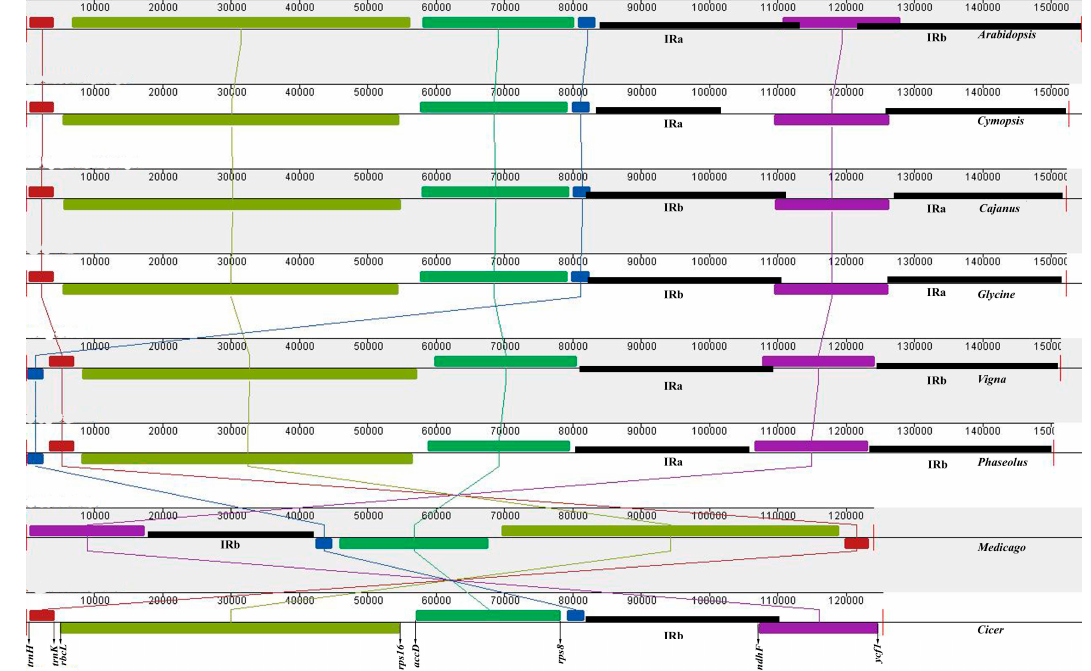
Figure 2. Gene order comparison of legume plastid genomes, with Arabidopsis Cp genome as reference, using MAUVE software. The boxes above the line represent the gene sequence in clockwise direction, and the boxes below the line represent gene sequences in the opposite orientation. The gene names at the bottom indicate the genes located at the boundaries of the boxes in Cp genome of pigeonpea.